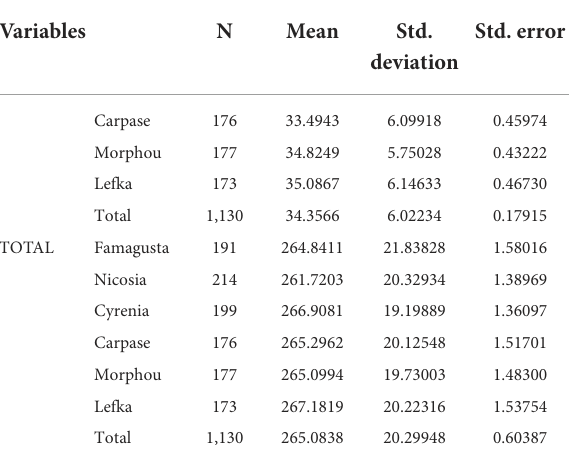
TABLE 5 Descriptive statistics of dependent variables across defined